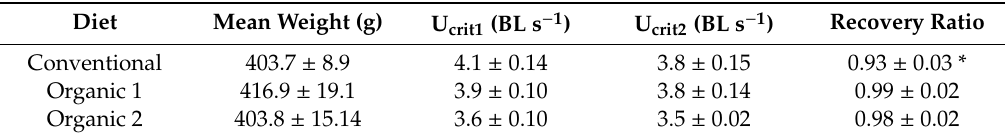
Table 3. Mean ± SEM of the relative U crit1 (BL s − 1 ), U crit2 (BL s − 1 ) and the recovery ratio values for the diet treatments.